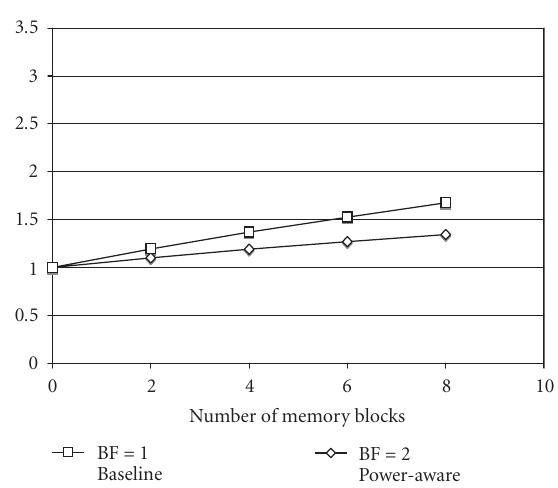
Figure 17: Impact on energy when increasing the number of 512- bit memories.